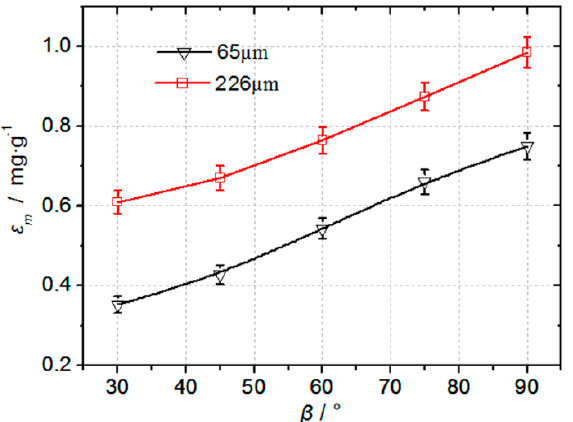
Figure 11. Comparison of the erosion rate curves for the quartz sand particles of 65 μ m and 226 μ m size at 210 m/s and 566 °C.